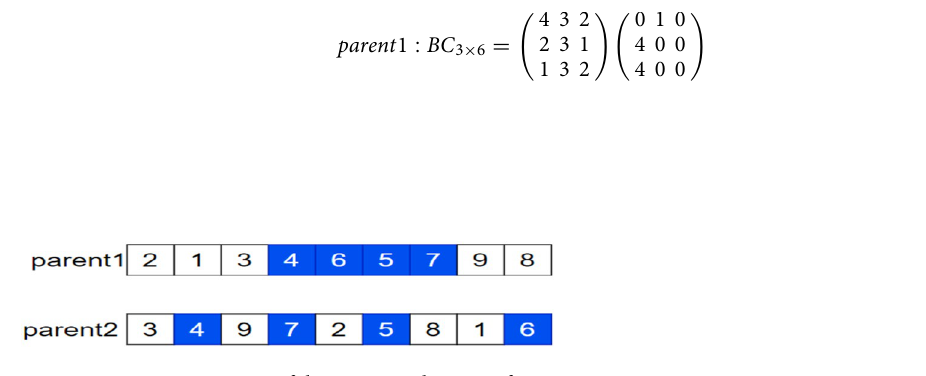
Figure 4. Genetic mapping of the parent at the time of gene crossover operations.